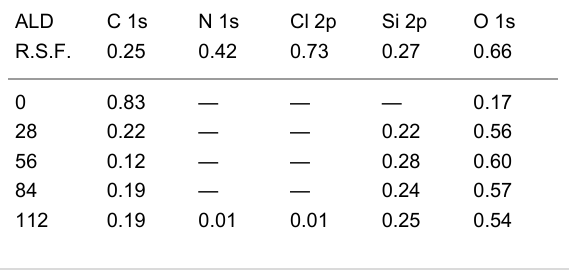
Table 1: Surface composition (in atom %) of a pristine PC membranes and SiO 2 -coated membrane after different numbers of ALD cycles. ALD